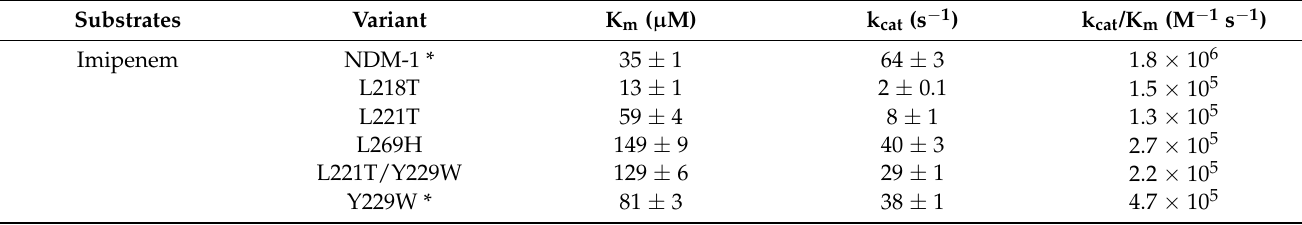
Table 1. Kinetic constants of L218T, L221T, L269H and L221T/Y229W compared with NDM-1 and Y229W.